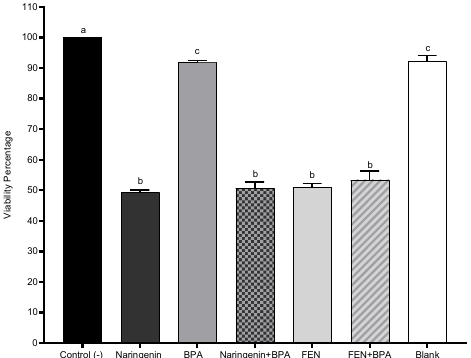
Figure 3. The effect of naringenin (250 µM), BPA (4.4 µM), FEN (37%), co-treatment naringenin and FEN with BPA, and blank of fermentation (10%) on HT-29 cells viability was evaluated after 24 h incubation by MTT assay. The experimental data are expressed as the mean value ± SD of the three independent experiments with three replicates each one. Letters indicate statistical difference ( p < 0.05).